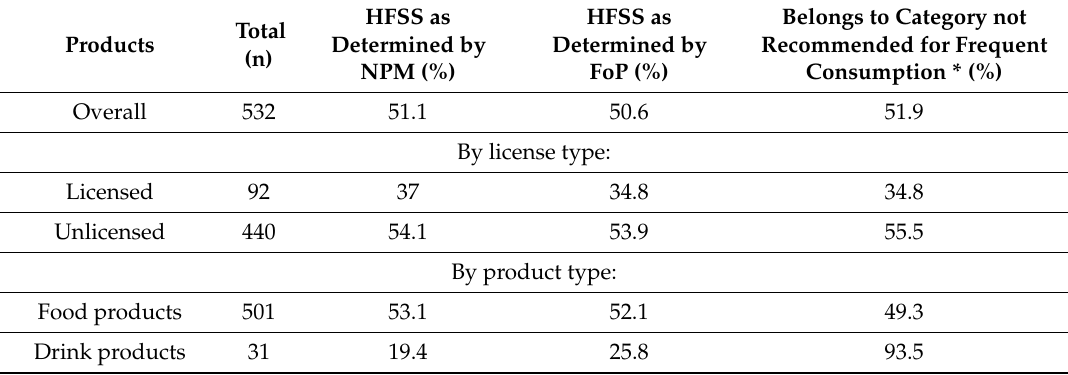
Table 1. Summary of food and drink products deemed HFSS as determined by the Nutrient Profiling Model (NPM) and UK Front of Pack nutrition labelling system